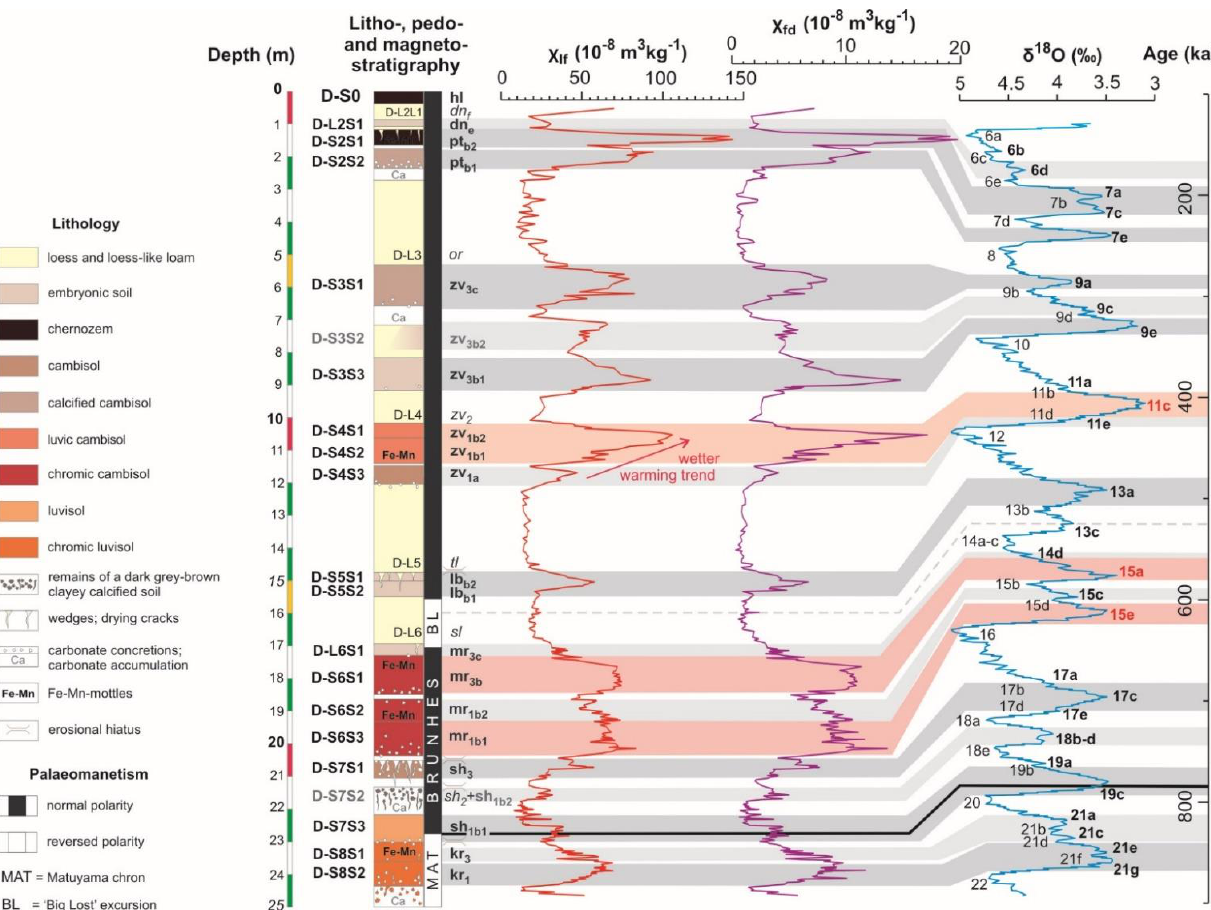
Figure 3. Low-field ( χ lf ) and frequency dependence ( χ fd ) magnetic susceptibility variations along lithological column of the Dolynske section, and proposed correlation with global marine isotope LR04 stack of Lisiecki and Raymo [242] (lettered substages adapted from Railsback et al. [243]. Magnetostratigraphic results are described in Section 3.5. Chronostratigraphic interpretation relative to marine isotope stratigraphy is given in Section 4.2.